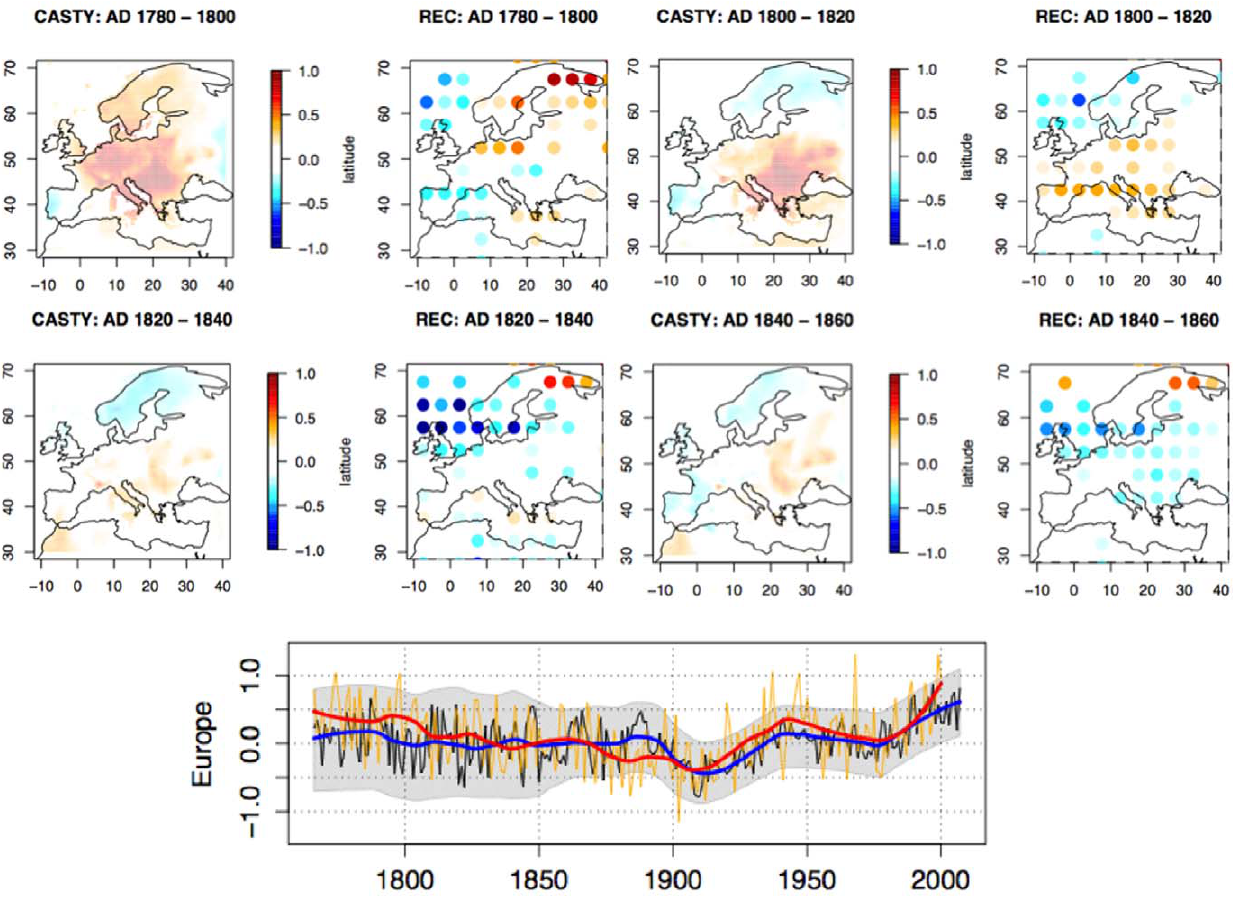
Figure 3. Comparison of the reconstruction of the April to September temperature anomalies (this paper) with the one produced by [ 19 ] . The above panel presents maps for several time periods. The CASTY maps have a 0.5 u resolution while the reconstruction in this paper has a resolution of 5 u . The lower panel show the mean temperature for Europe: in orange, the CASTY series (trend in red) and in black, this paper’s reconstruction (trend in blue) with (in grey) the 90% confidence interval.